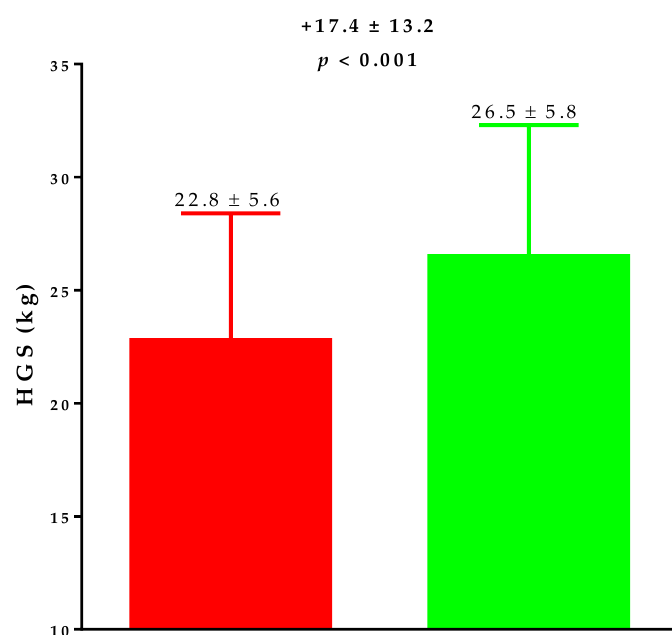
Table 3. Anthropometric measurements, body composition, and hs-CRP levels of the study popu- lation baseline grouped according to the cut-off of HGS. Participant Baseline n = 247 Parameters